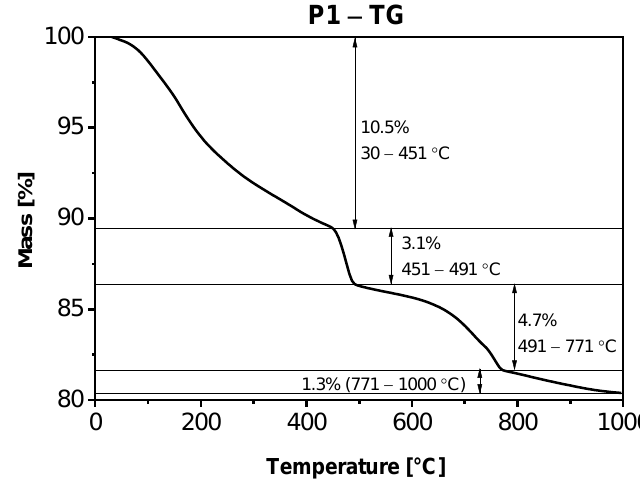
Figure 6. TGA of sample P1 after 28 days of curing.